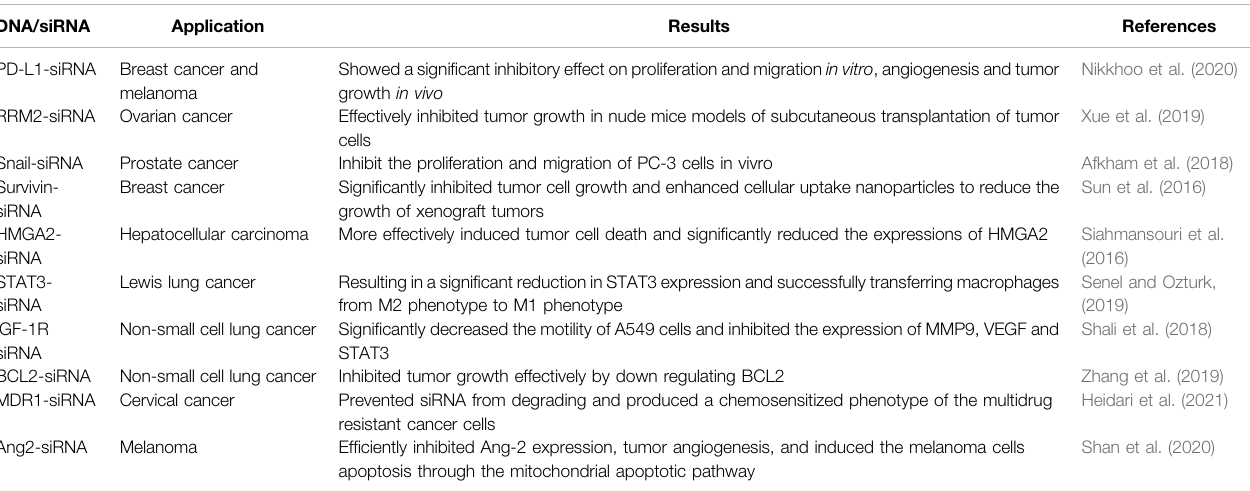
TABLE 2 | A few examples of chitosan based therapeutic genes nanoparticles and their application in oncotherapies over the last